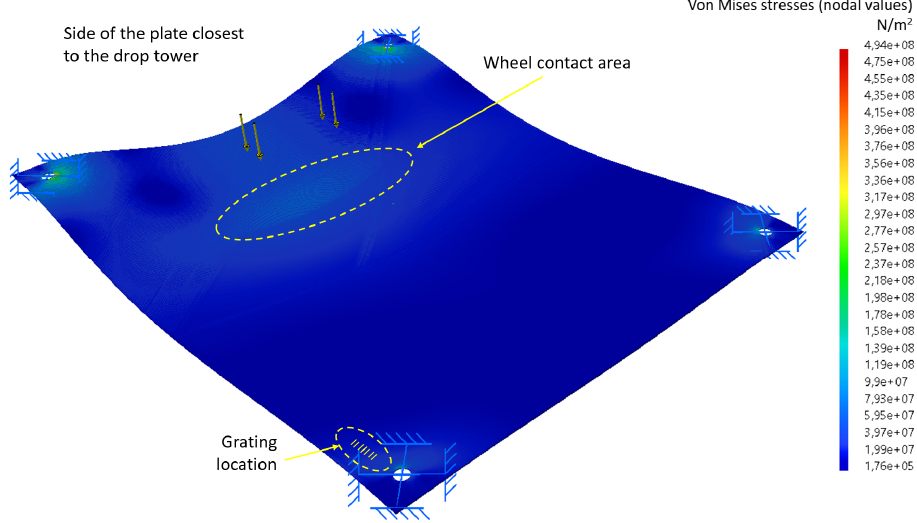
Figure 6. Von Mises Stresses on the impact plate under the wheel-transmitted loads.